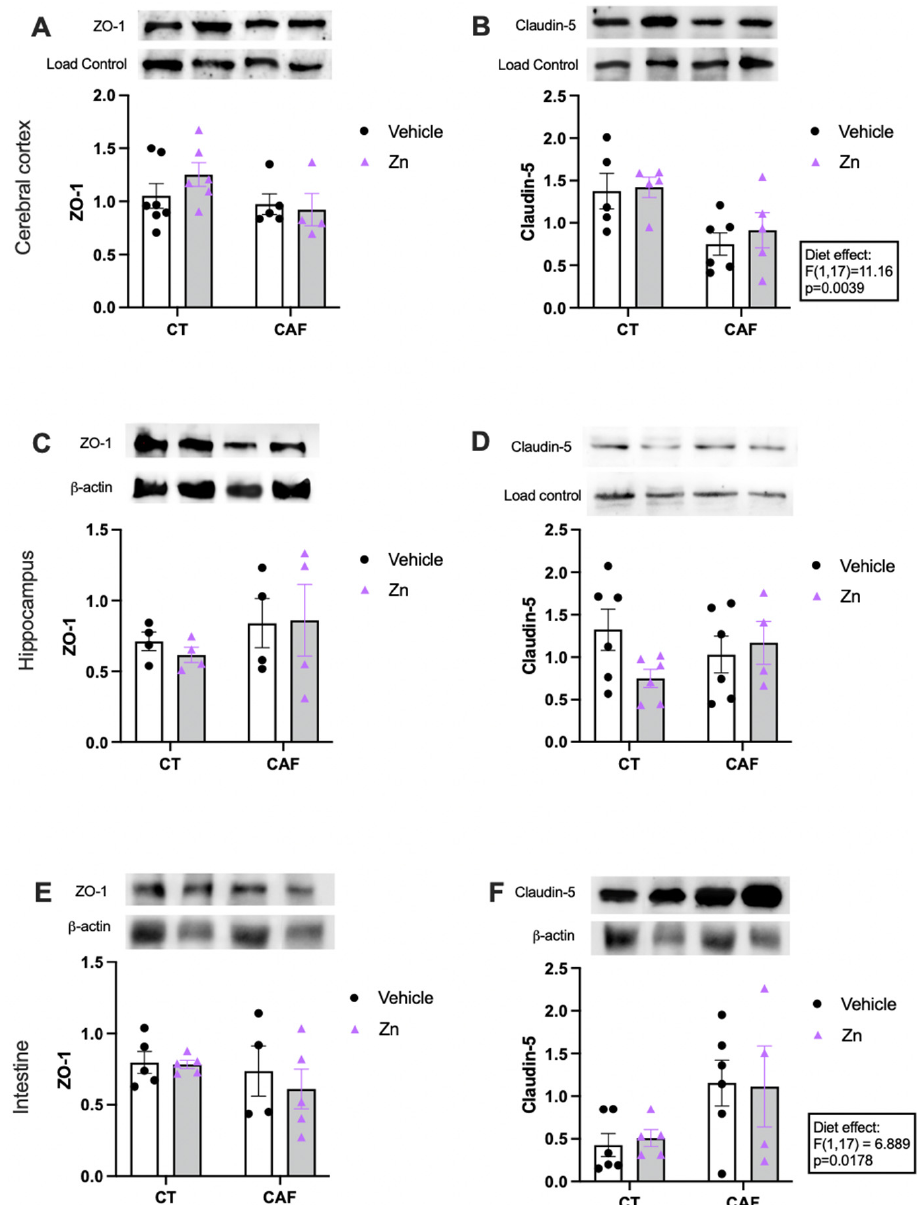
Figure 4. Protein expression of zonula occludens 1 (ZO-1) and claudin-5 in cerebral cortex ( A , B ), hippocampus ( C , D ), and proximal portion of the intestinal colon ( E , F ) in control (CT) and cafeteria diet (CAF)-fed rats. Representative bands of each group are shown on the top of the graphs. β -actin or nonspecific bands were used as a loading control. The text box indicates significant differences shown by two-way ANOVA regarding effects of the diet (CT and CT + Zn vs. CAF and CAF + Zn). n = 4–7 animals/group.